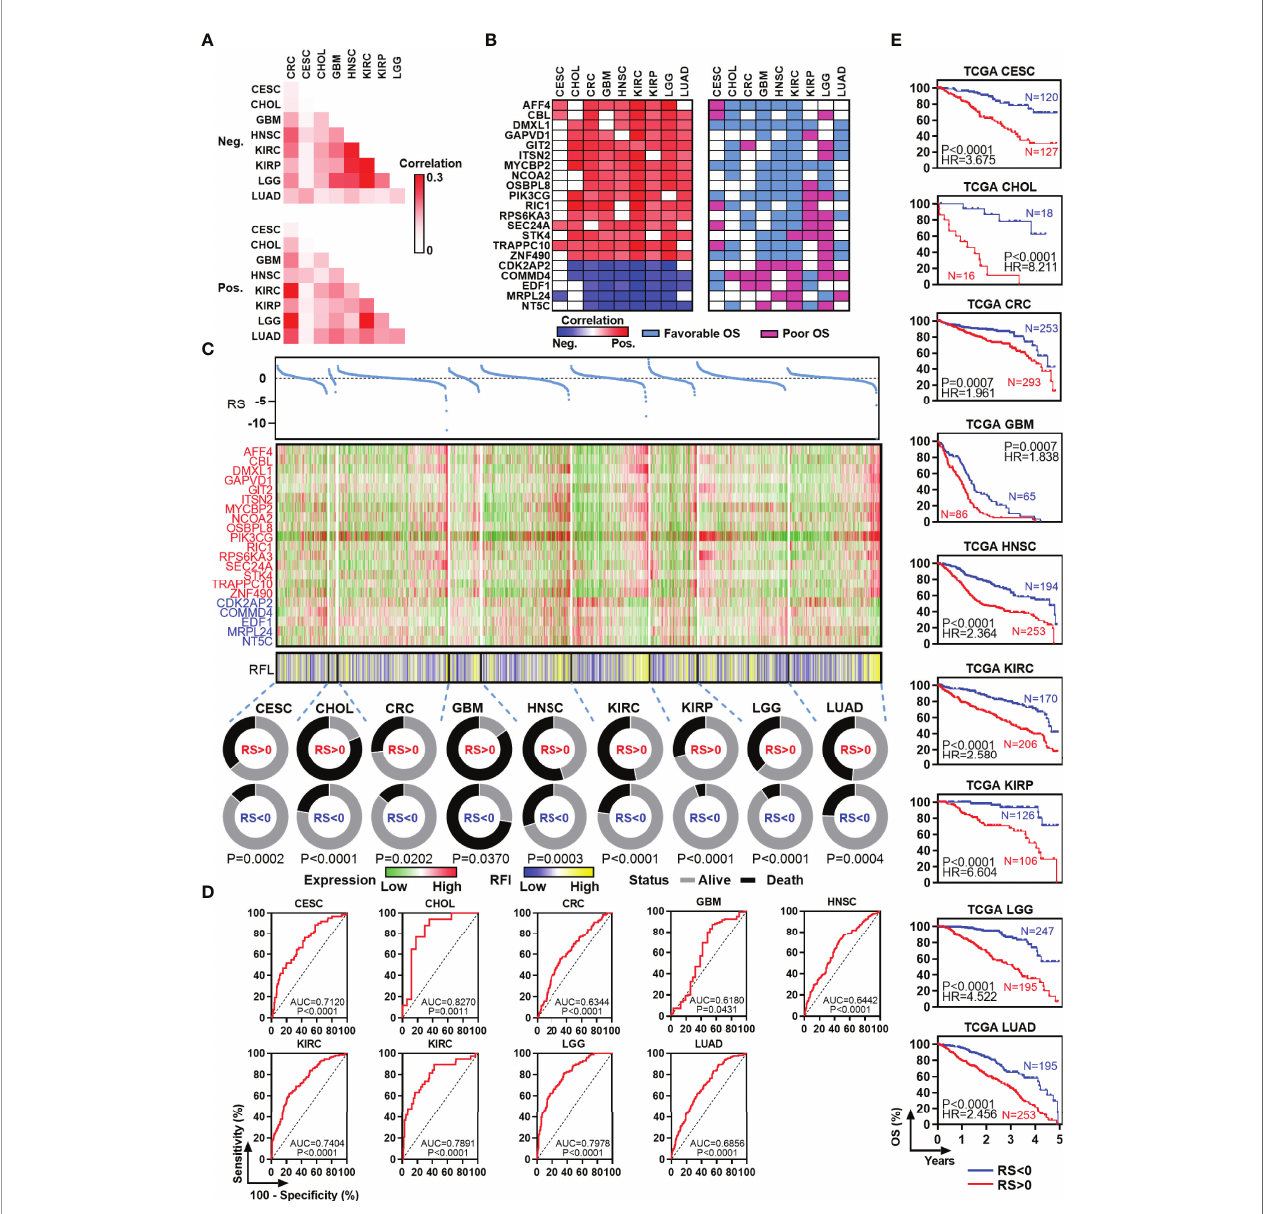
FIGURE 3 | Identi fi cation and survival analysis of RFL-correlated genes. (A) Heatmap visualizing the matrix of Jaccard indices of the shared connections for the negative upregulated (top) and positive (bottom) RFL-correlated genes of each cancer from the TCGA. (B) Heatmaps showing the correlation level between RFL- correlated genes and RFL (left), as well as survival type (right). (C) Multivariate COX regression models showing the effect to OS of RS based on 21 RFL-correlated genes in TCGA cohorts. Dot plot shows the risk score (top). Heatmaps showing the 21 RFL-correlated genes and RFL levels (middle). Pie charts show the OS status in RS <0 and RS >0 groups (bottom). (D) ROC plots showing the AUC of survival based on the RS in TCGA cohorts. (E) Kaplan – Meier plots show that high RS cases were associated with poor OS time in multiple cancer types from the